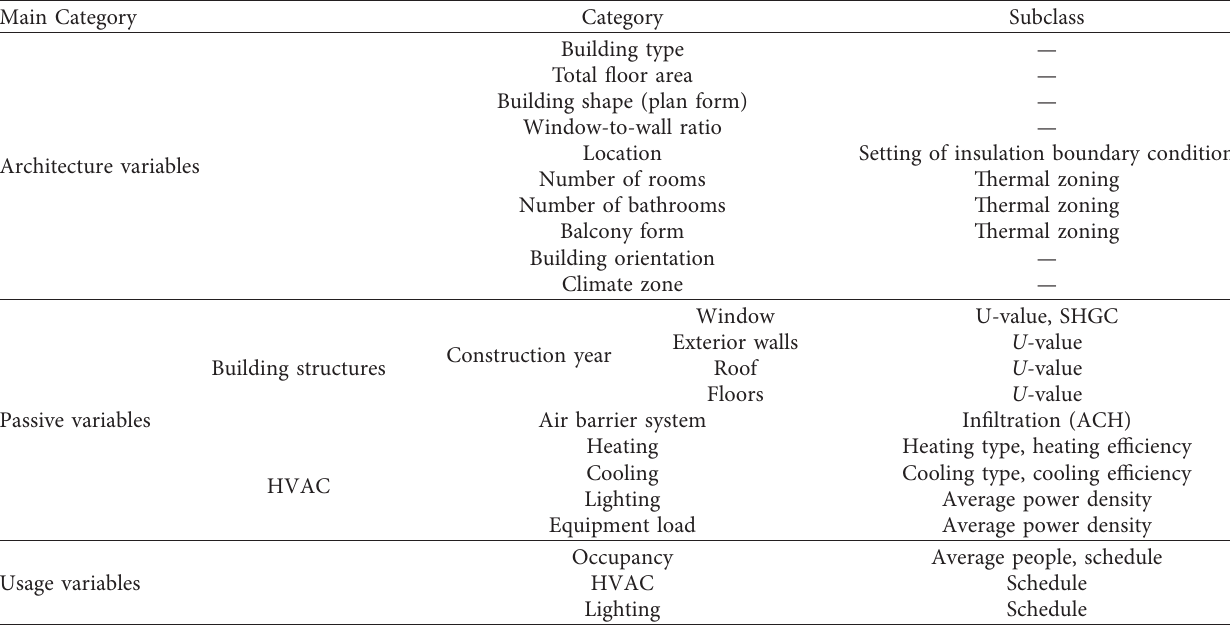
Table 2: List of energy variables used in this